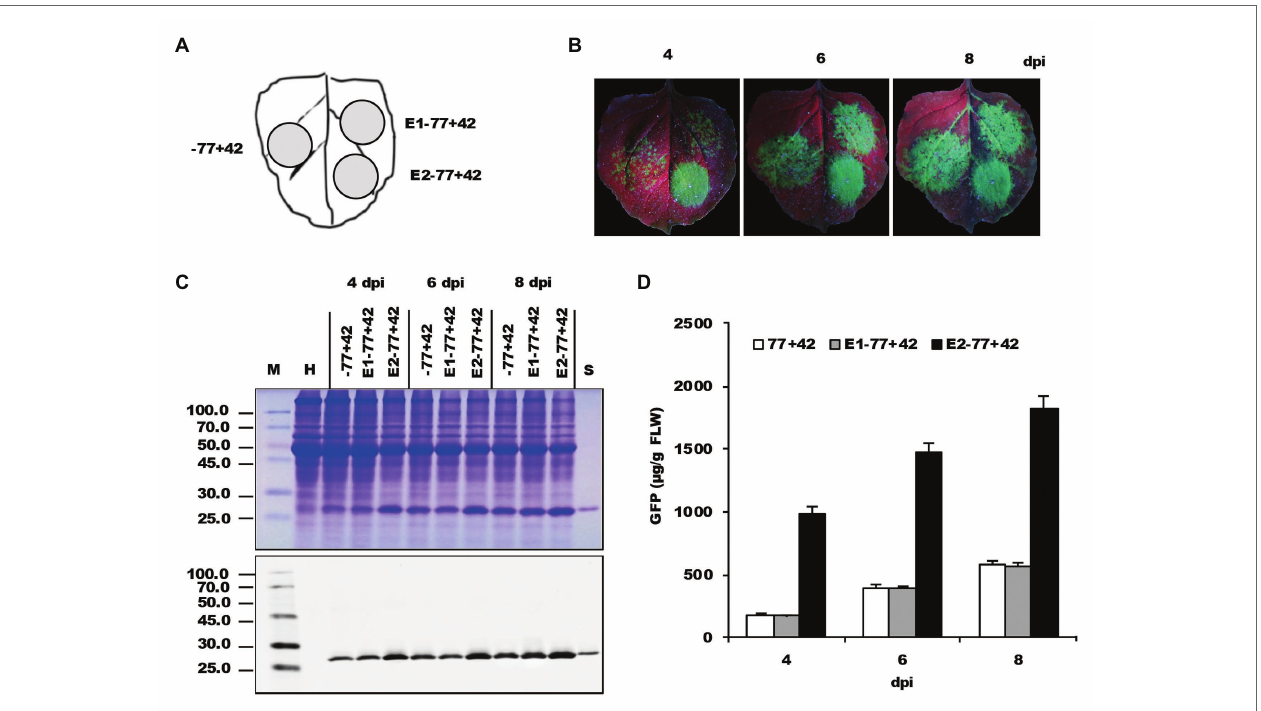
FIGURE 3 | The effects of two enhancers on the expression of recombinant proteins. (A) Schematic representation of the agroinfiltrated zones in N. benthamiana leaf. (B) GFP expression pattern (under UV light) of agroinfiltrated N. benthamiana leaves at 4, 6, and 8 dpi, respectively. (C) SDS-PAGE analysis and immunodetection of proteins isolated from the agroinfiltrated zones of N. benthamiana leaves. The gel was stained with Coomassie brilliant blue (upper panel) and the corresponding antibodies were used to detect GFP (lower panel) in agroinfiltrated N. benthamiana leaves by Western blots. M, molecular weight marker (kDa); H, total soluble protein extracts from uninoculated leaves; − 77+42, E1 − 77+42 and E2 − 77+42, total soluble protein extracts from the corresponding agroinfiltrated zones of N. benthamiana leaves in (A) . (D) Time course for the accumulation of recombinant GFP protein in N. benthamiana leaves by